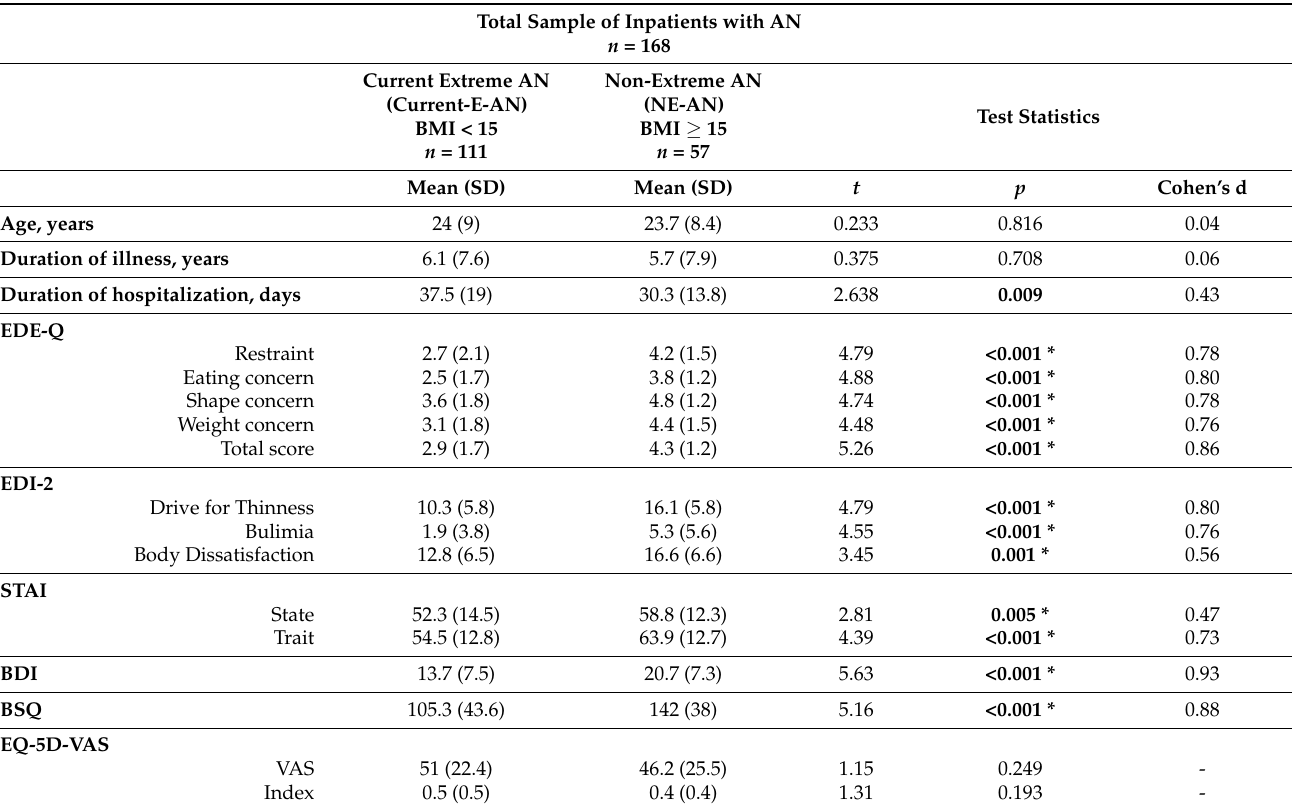
Anxiety Inventory-State; BSQ = Body Shape Questionnaire; EQ-5D-VAS: EuroQoL Health Questionnaire/Visual Analogue